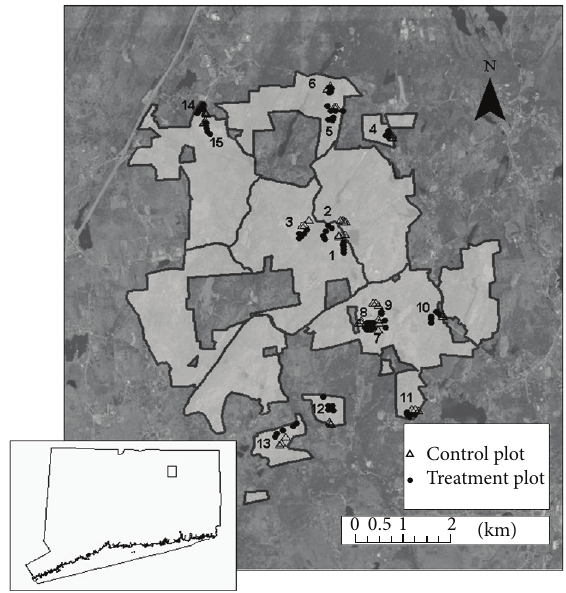
Figure 1: Locations of each of the 15 shelterwood treatment and adjacent control sites in the Yale-Myers